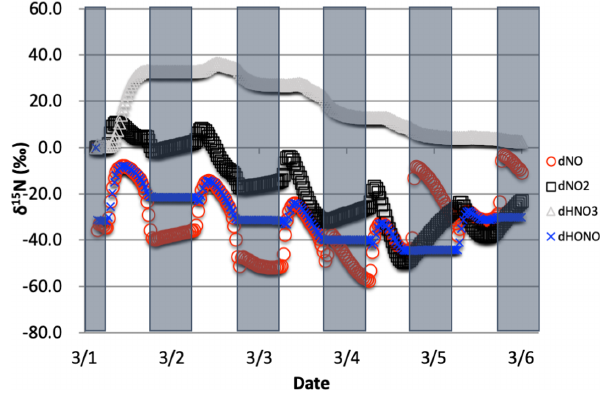
Figure 10. The time evolution of δ 15 N values of NO, NO 2 , HNO 3 , and HONO caused by isotope effects of Leighton reactions, NO x isotope exchange, and NO 2 + OH reaction, with NO emission. The simulation starts from 1 March. The 5d simulation was under the conditions list in Table